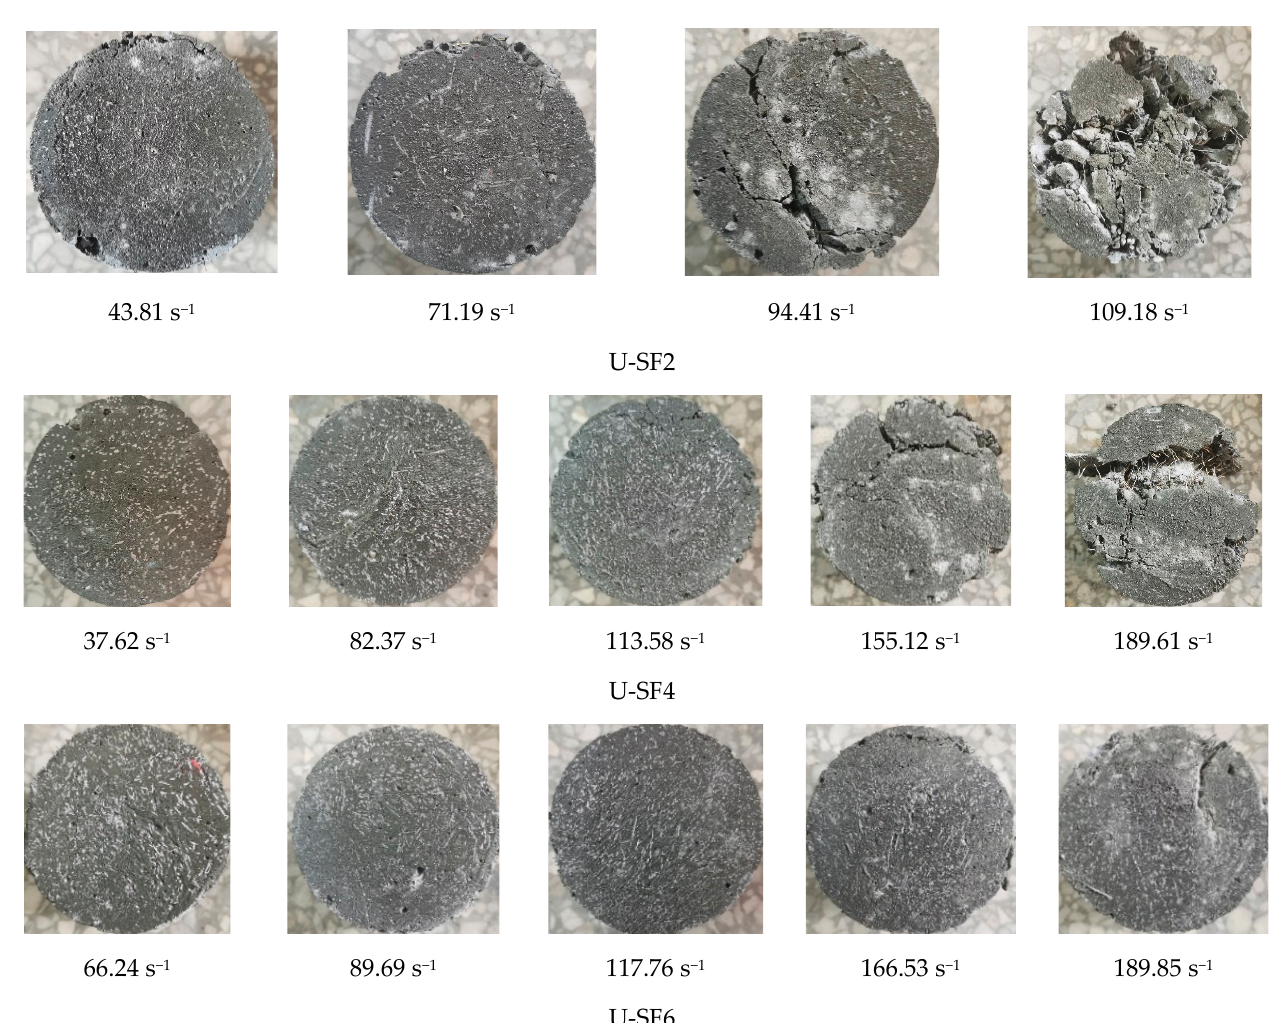
Figure 9. Failure pattern of fiber in non-oriented UHPC impact compression test. Fiber-oriented specimens had unique appearance characteristics in the form of impact compression failure, as shown in Figure 10. After undergoing impact compression loads, all cracks were in the same direction as the fiber center line. The D-SF2 specimen showed the clearest failure mode at the strain rate of 152.97 s − 1 . The two main fracture surfaces are completely consistent with the fiber orientation, and several other fracture branches also maintained a small angle. This phenomenon was mainly because, in the direction of the fibers, even if the concrete produces great stress and transverse expansion, there were still a lot of fibers between the specimens to provide a bridging effect, which inhibits the development of cracks in the specimens. However, in the direction perpendicular to the fiber, the fiber can provide very little bridging force to the matrix. At the same time, the cracks in the fiber direction were also distributed in the vertical direction, so there was a large deformation in the vertical direction, resulting in parallel cracks or z-shaped